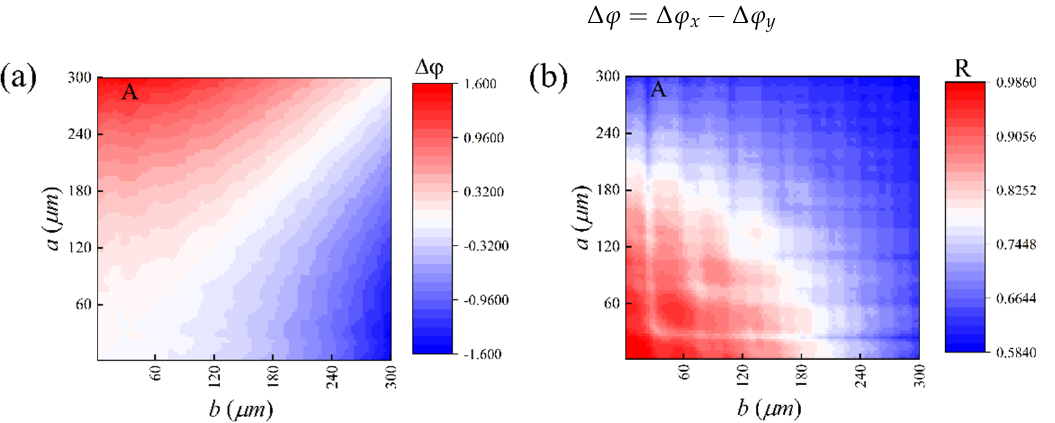
Figure 4. ( a ) The phase difference and ( b ) the reflectance of each antenna structure for different lengths of the major and minor axes. The temperature is T = 300 K, and the operation frequency is f 0 = 0.228 THz.